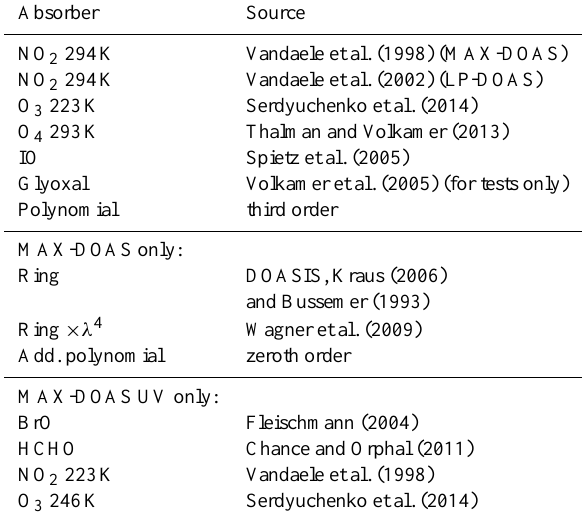
Table 2. The cross-sections that were used for the spectral retrieval. All shift and squeeze parameters of the cross-sections were linked to each other, while those of Ring, measurement and reference spectra were linked